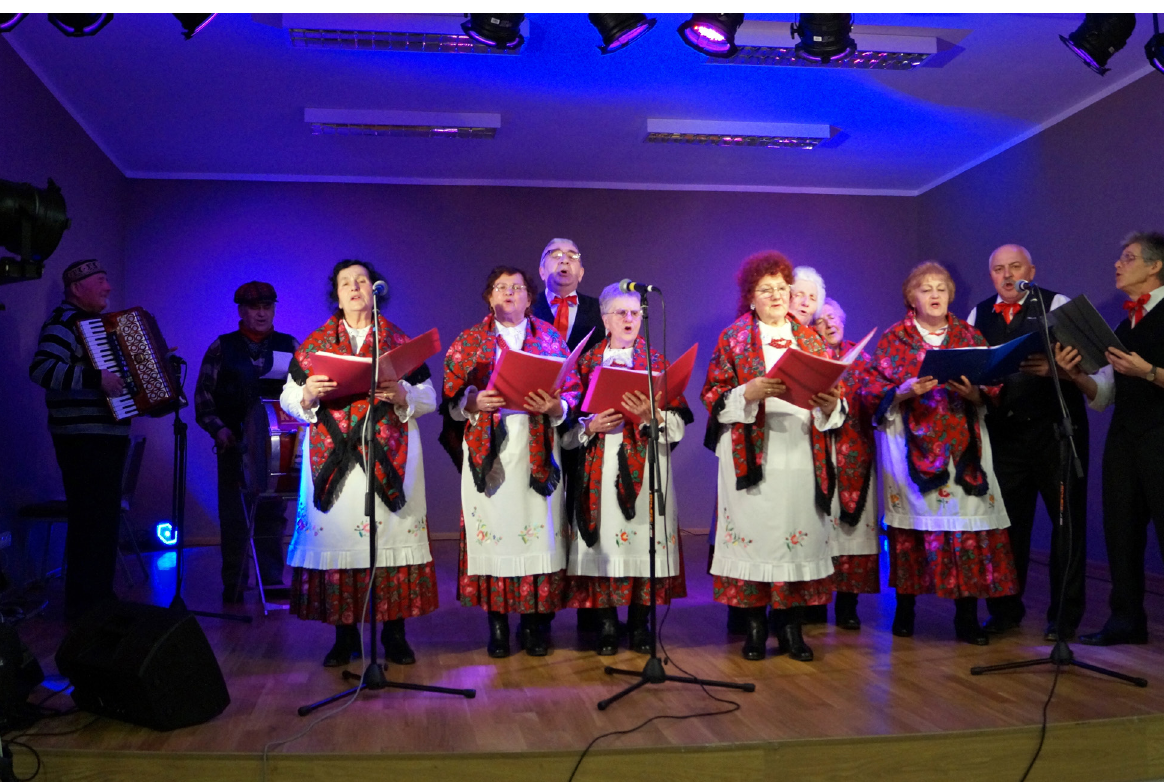
Fig. 6. The Ślężanki Folk Group during a performance at the culture centre in Borek Strzeliński in 2017. Source: S. zawer/communal public library in